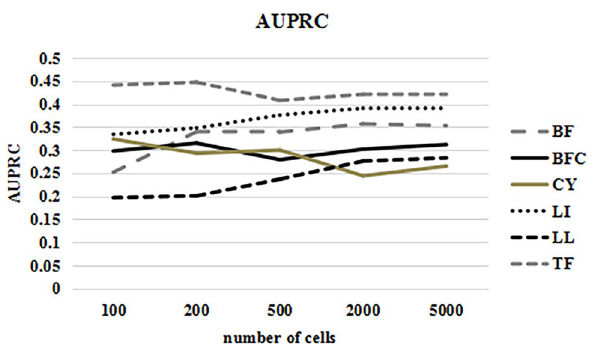
Figure 3. The AUPRC for datasets with different types and containing different numbers of